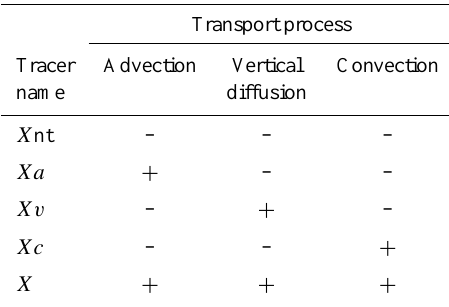
Table 3. Table of passive tracers for the transport test with PTRAC. X is a placeholder for either H , V 1 or V 2 and refers to the initiali- sation patterns (Tab. 2).